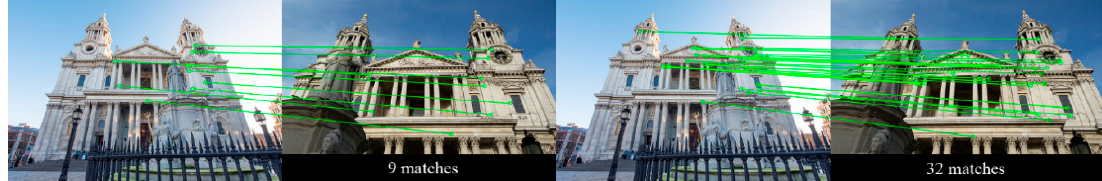
Figure 6. Local-image-feature matching examples of (left) Scale Invariant Feature Transformation (SIFT) and (right) Learned Invariant Feature Transform (LIFT).